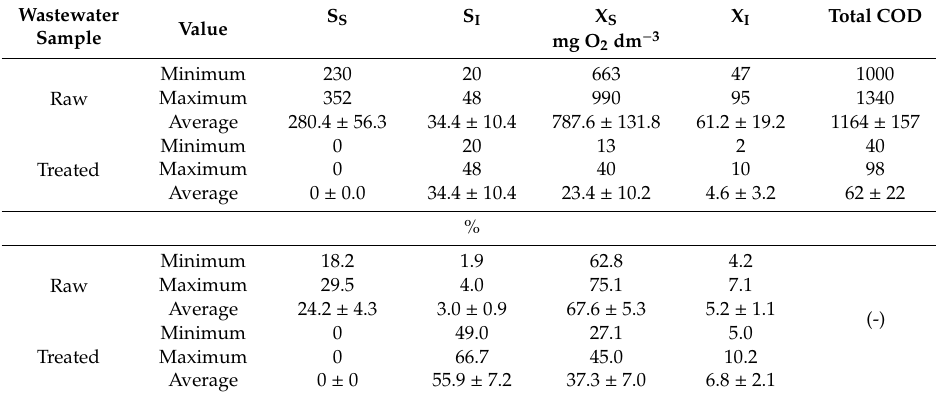
Table 4. COD fractions in raw wastewater and treated according to the ATV-A131